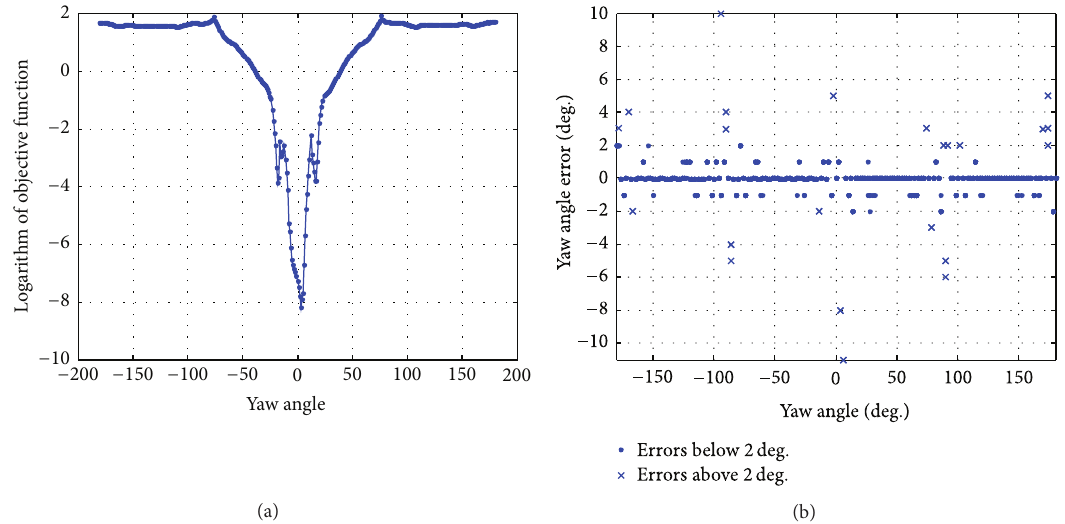
Figure 11: (a) Logarithm of objective function of (6) obtained after a line search conducted for a test point with a yaw angle of 0 degrees. (b) Yaw angle prediction errors on the RALS tower data when training was conducted on data at every 4-degree increments of yaw angle using the forward approach.